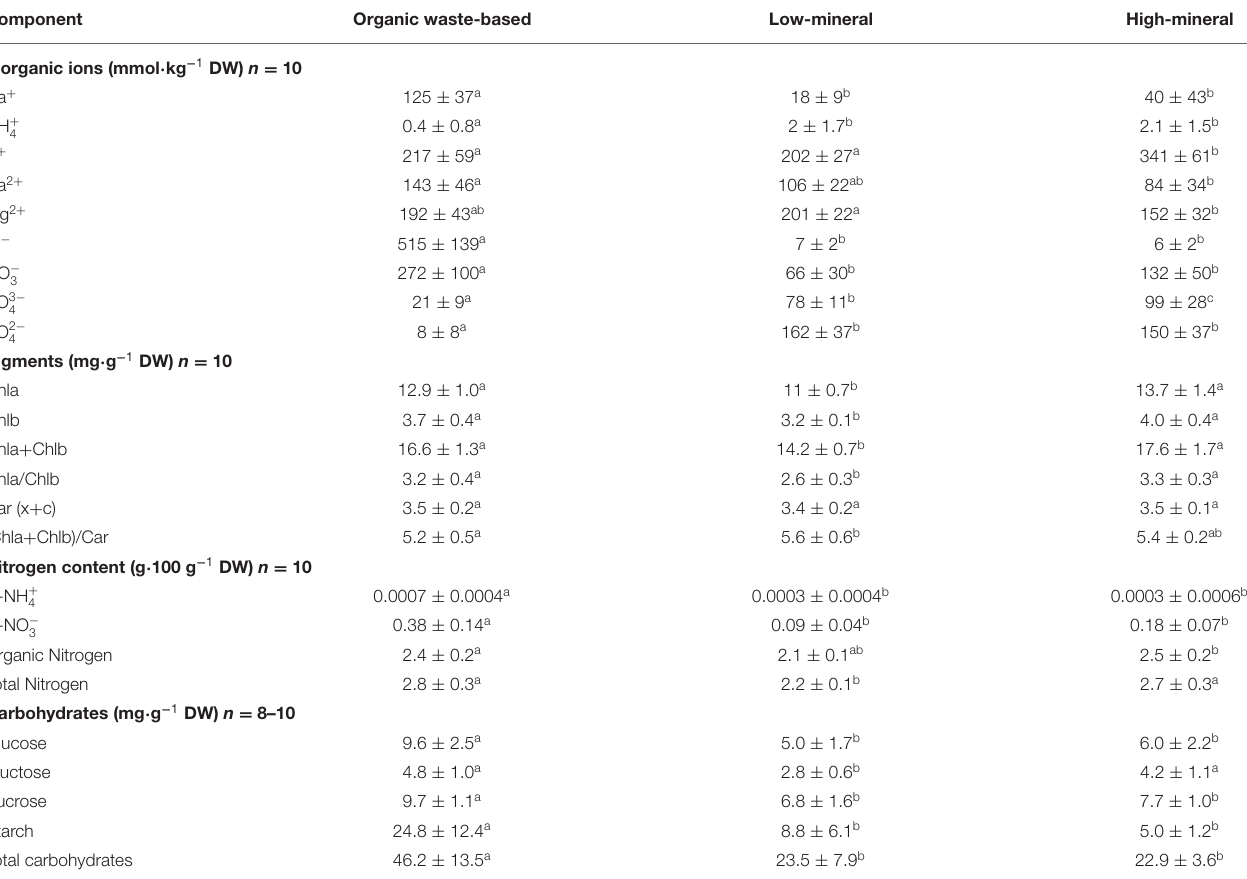
TABLE 5 | Ionic and carbohydrate composition of tomato leaves grown under different nutrient conditions. Chla (b), Chlorophyll a (b); Car, carotenoids. Component Organic